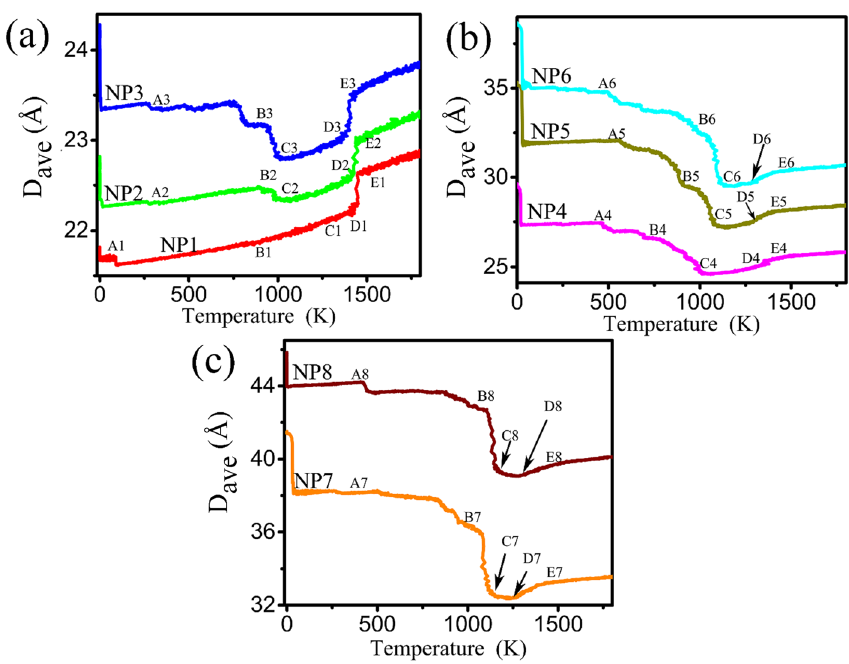
Figure 7. Temperature dependence of D ave , during the coalescence. ( a ) NP1, NP2, NP3 ( b ) NP4, NP5, NP6 ( c ) NP7,